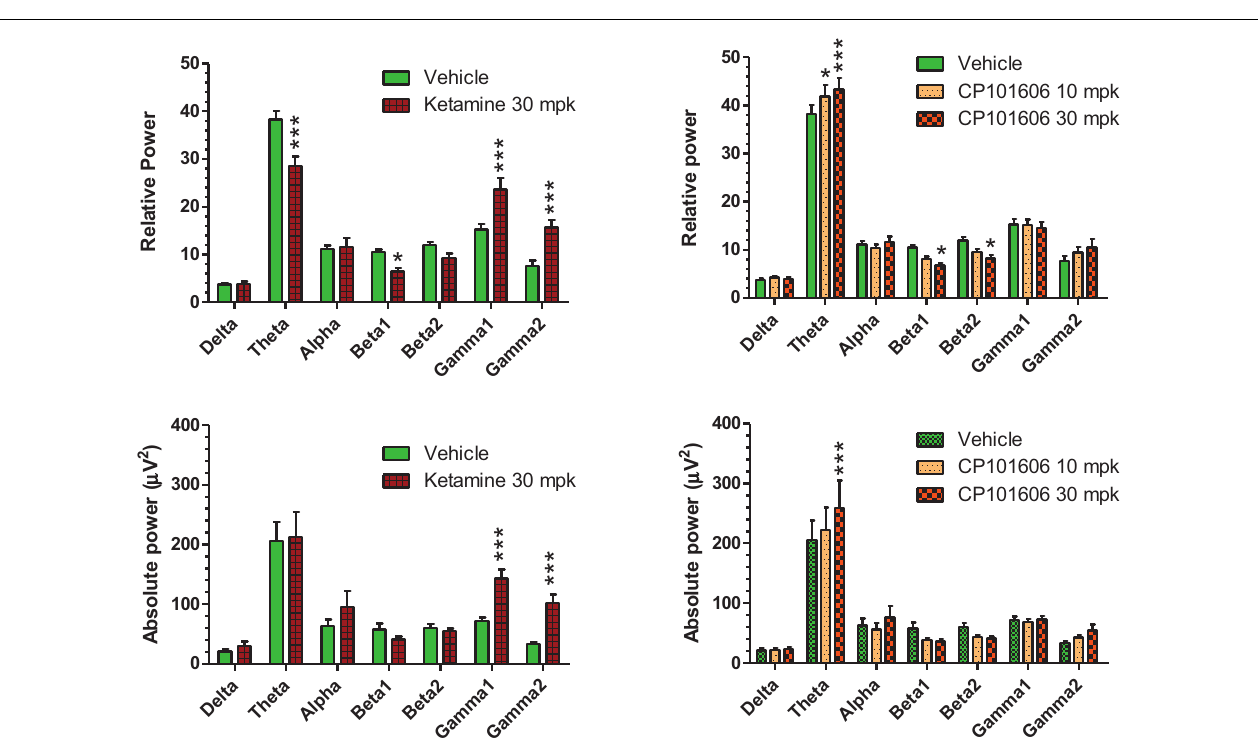
FIGURE 10 | Summary graphs of quantitative EEG parameters analyzed approximately 30min after vehicle or ketamine (30mg/kg, ip), or CP-101,606 (10 or 30mg/kg, sc) treatments . */***Indicate P < 0.05/ P < 0.0001, respectively (Bonferroni